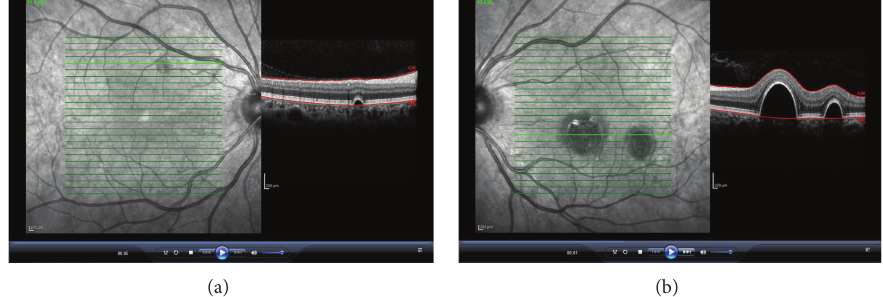
Figure 2: OCT cross-section images of these lesions showed serous PED in the right eye (a) and in the left eye